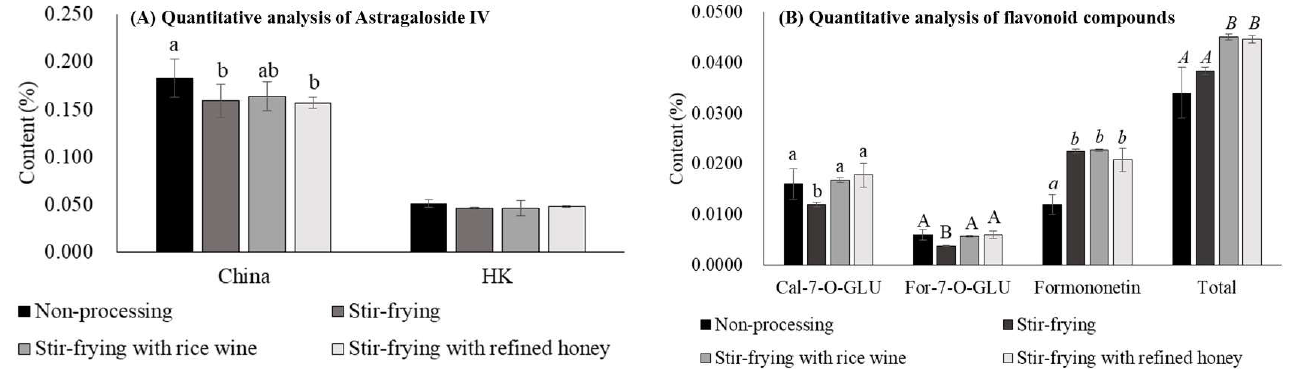
Figure 6. Effects of diverse processing methods on the content of Astragaloside IV ( A ) and flavonoids ( B ) in Astragali radix with a diameter of 0.6–0.9 cm. Data are expressed as mean ± SD from three separate experiments; means not sharing an alphabetic letter (left panel: lowercase for China; right panel: lowercase for Cal-7-O-GLU, uppercase for For-7-O-GLU, italic lowercase for formononetin, and italic uppercase for total flavonoids) differ statistically ( p < 0.05). Total flavonoids is the sum of Cal-7-O-GLU, For-7-O-GLU, and formononetin. Abbreviations (alphabetically): Cal-7-O-GLU, Calycosin-7- O -β- D -glucopyranoside; China, the Pharmacopoeia of China; For-7-O-GLU, Formononetin-7-O-glucoside; HK, the Hong Kong Chinese Materia Medica Standards.